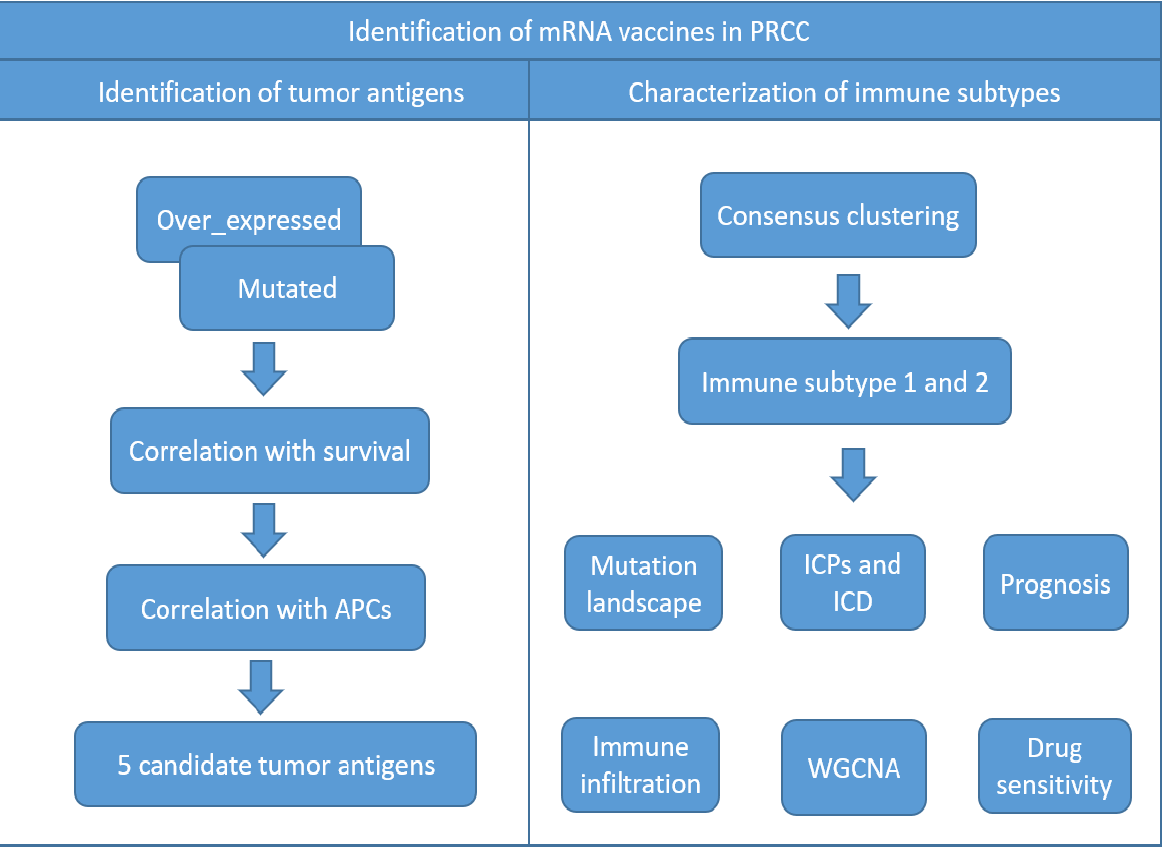
Figure 1. The work flow of the study.